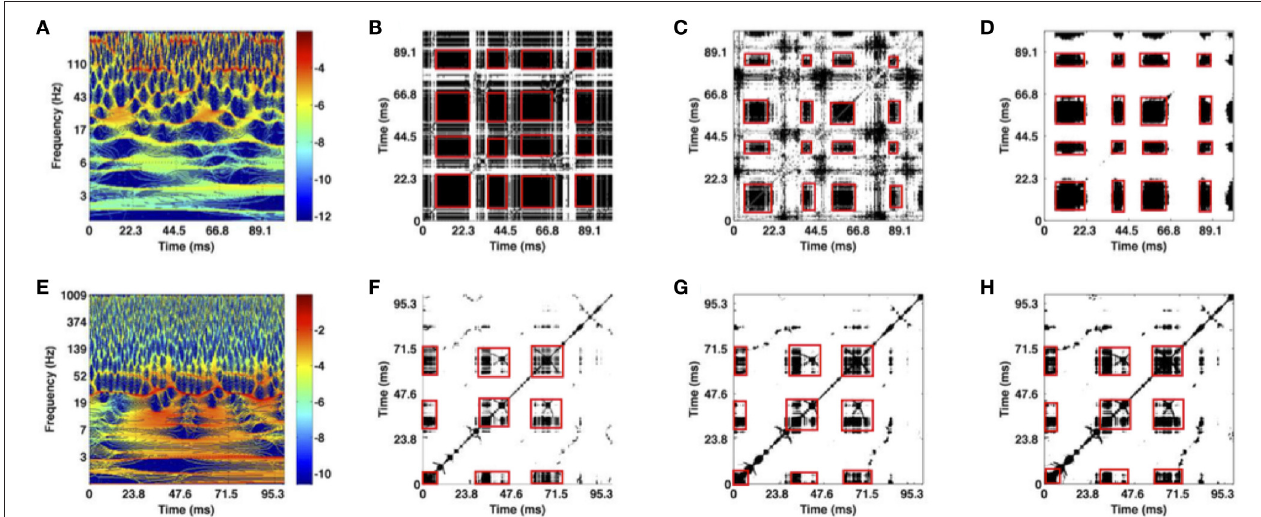
FIGURE 5 | Illustration of time-frequency (A,E), optimal recurrence plot (B,F) for the trials of two artificial datasets shown in Figures 3A,B, statistically significant recurrence plots (C,G) based on 10 trials and classical t -test results (D,H). Values plotted in black represent areas where the original and the surrogate set differ significantly (rejected test). (A–D) Transient oscillations; (E–H) Lorenz attractor. The red boxes mark recurrent metastable states.